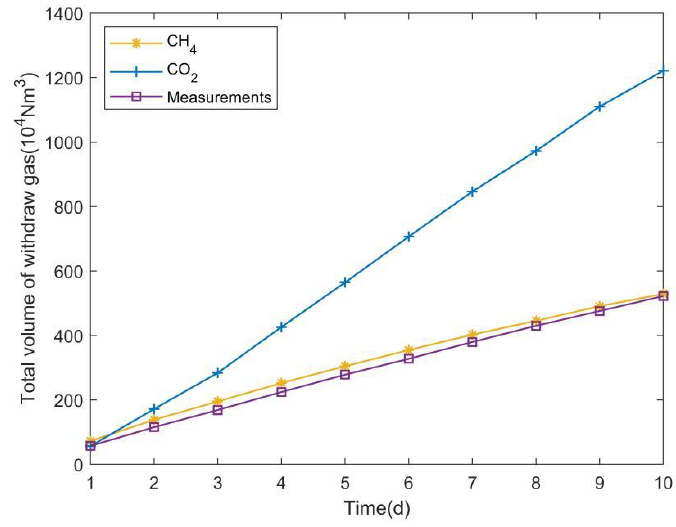
Figure 16. Total gas withdrawal volume.